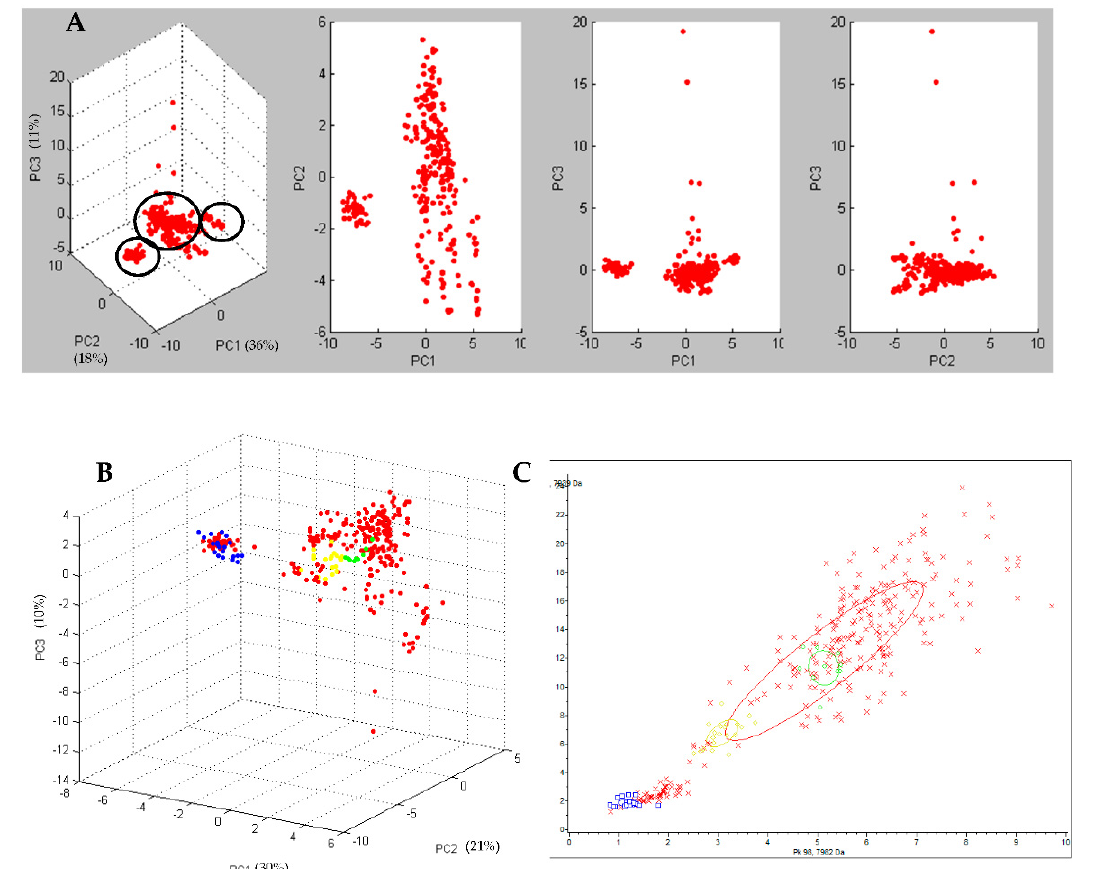
Figure 2. In ( A ) three-dimensional plot of all the 28 C. difficile strains, obtained by Principal Component Analysis (PCA) grouped in 3 different clusters (circled in black). Dots represents the single spectra. In ( B ) three-dimensional plot of all the 28 C. difficile strains (red), compared to Ribotype 126 (blue), Ribotype 018 (yellow), and Ribotype 127 (green). Dots of the same colour represent the single replicates of the same class. In ( C ) 2-D distribution of all the 28 C. difficile strains (red), compared to Ribotype 126 (blue), Ribotype 018 (yellow), and Ribotype 127 (green). The “x” of the same colour represents the single replicate of the same class.